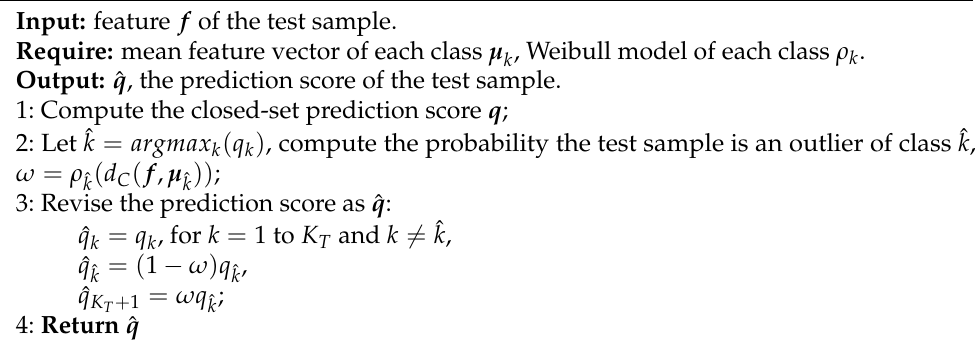
Algorithm 2 The inference algorithm for adaptive class-wise OpenMAX.